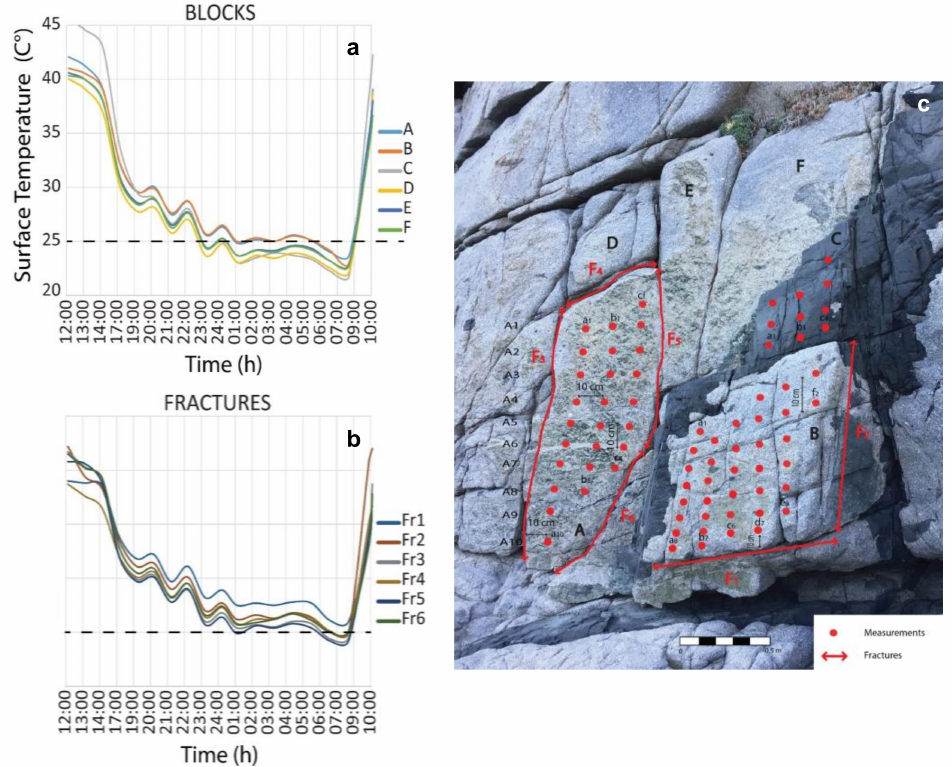
Figure 6. Cooling and heating patterns of ( a ) blocks and ( b ) fractures computed by thermograms. Blocks and fractures are shown in ( c ): Fr1 and Fr2 are open fractures with a length of 0.6 m; Fr3 is a semi-open fracture with a length of 1.2 m; Fr4 is an open fracture with a length of 0.4 m; Fr5 is a semi-open fracture with a length of 0.7 m; and Fr6 is a semi-open fracture with a length of 0.6